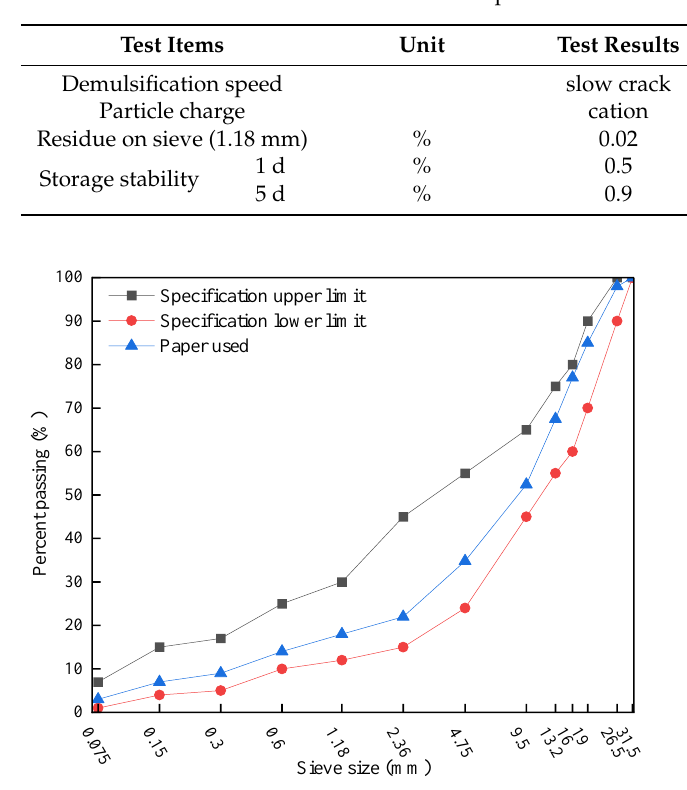
Table 2. Main technical indexes of emulsified asphalt.